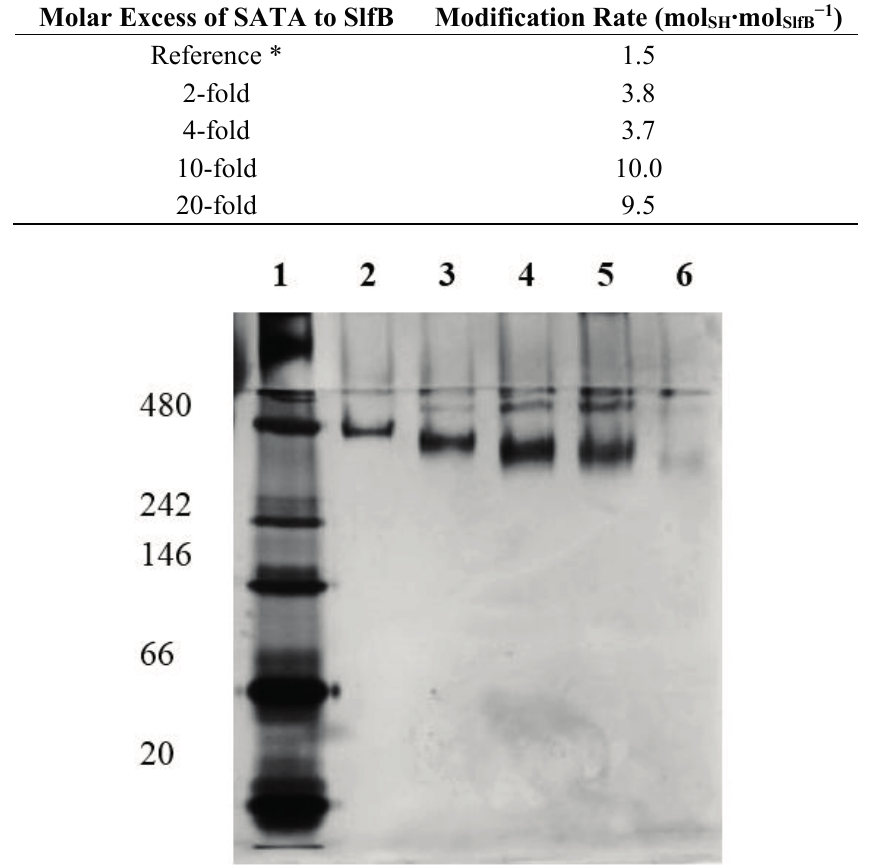
Figure 1. Native PAGE of SlfB modified with different molar excess of SATA; lane 1—molecular weight standard with 480, 242, 66, and 20 kDa; lane 2—native SlfB; lane 3–6—SlfB modified with a 2-, 4-,10-, and 20-fold molar excess of